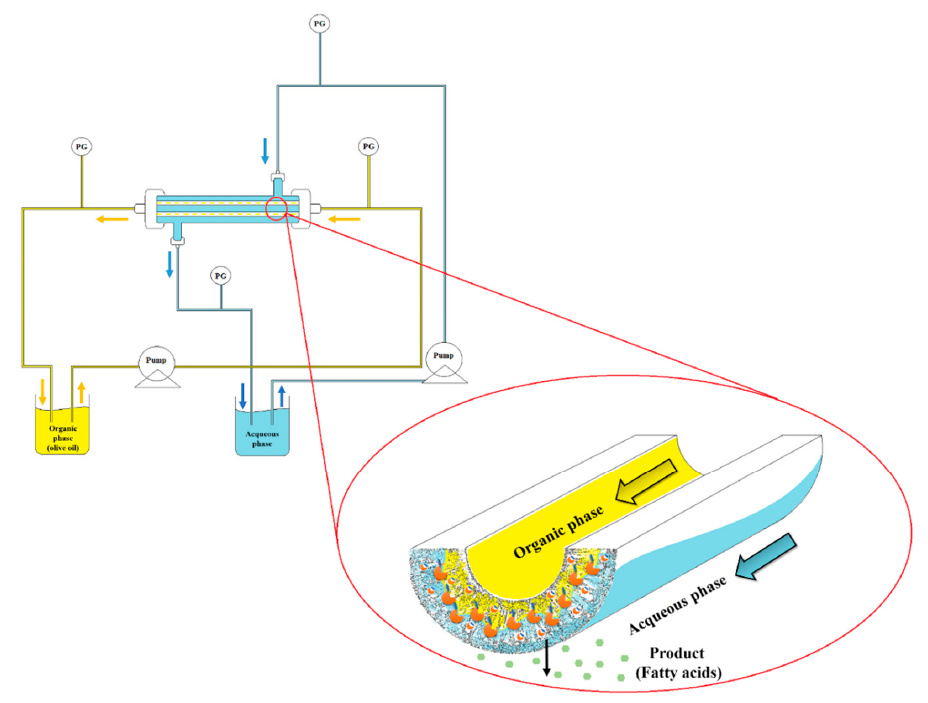
Figure 5. Schematic representation of two-separate-phase biocatalytic membrane reactor (TSP-BMR).